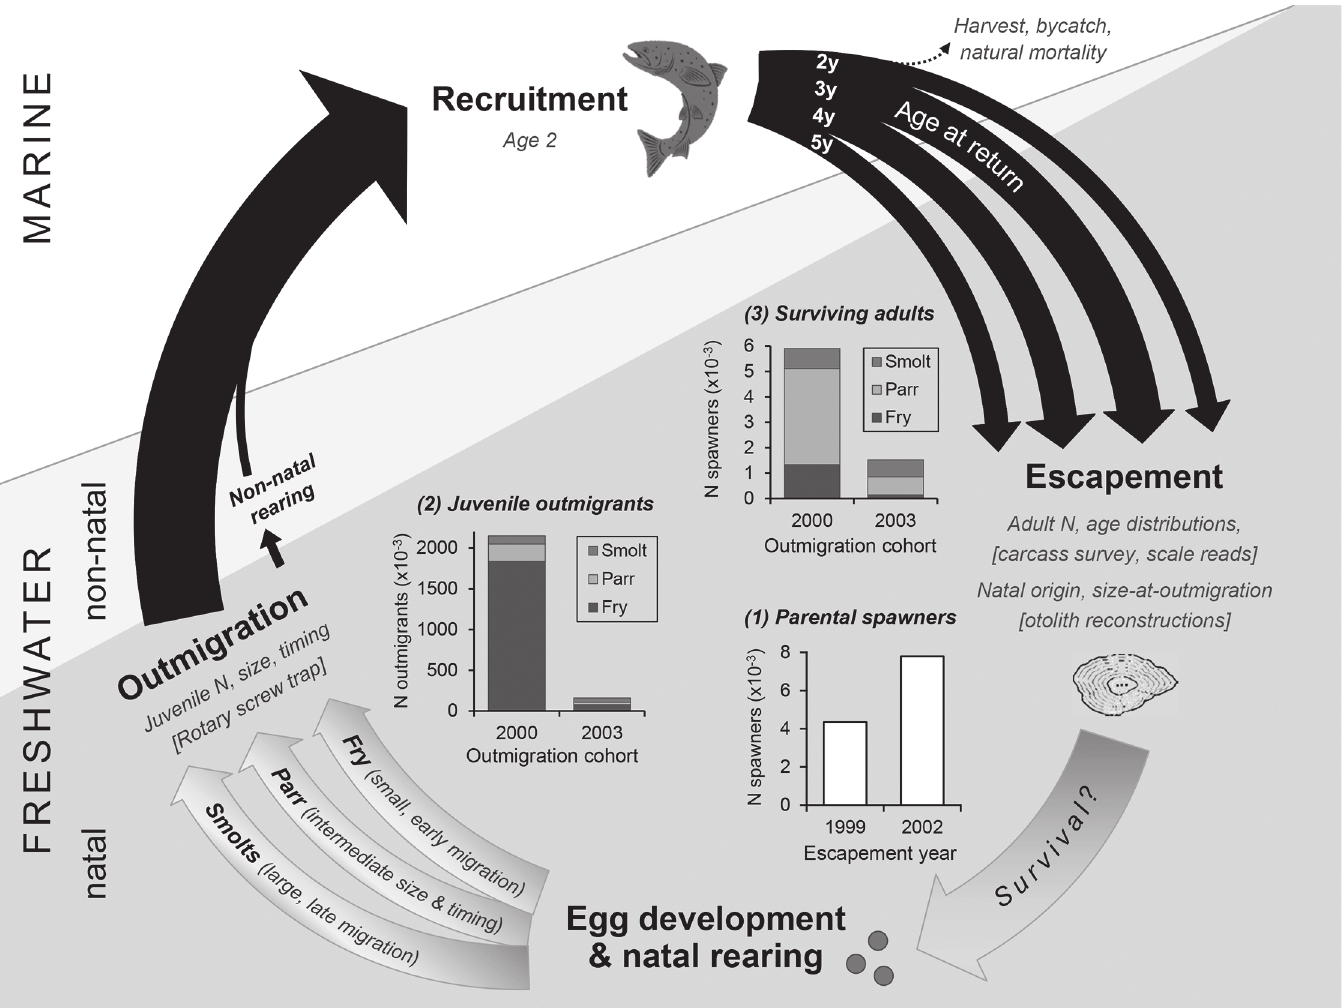
Fig 7. Schematic to conceptualize the data sources, methods and results presented in this study. This figure outlines the life cycle of fall-run Chinook salmon in the California Central Valley. Inset plot (1) demonstrates the abundance of parental spawners in the 1999 and 2002 escapement that contributed to the two focus years. Inset plots (2) and (3) illustrate the abundance and proportions of migratory phenotypes (fry, parr and smolts) observed in the juvenile sample (based on RST sampling) and in the adult escapement (based on otolith reconstructions), respectively. Arrow widths (not to scale) illustrate the typical proportions of 2, 3, 4 and 5 year olds observed in the adult escapement; note that age 5 fish tend to comprise < 1% of the returns